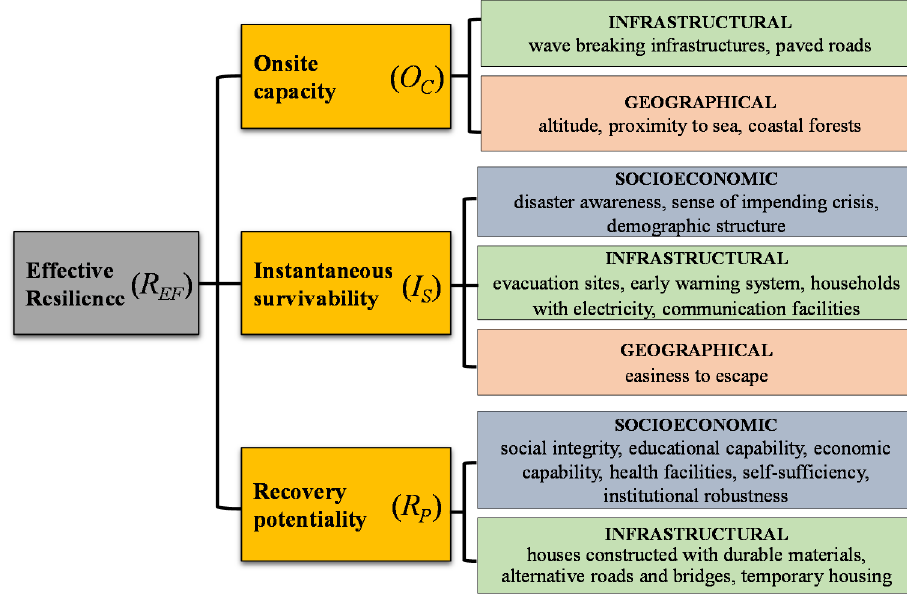
Figure 3. The conceptual framework.